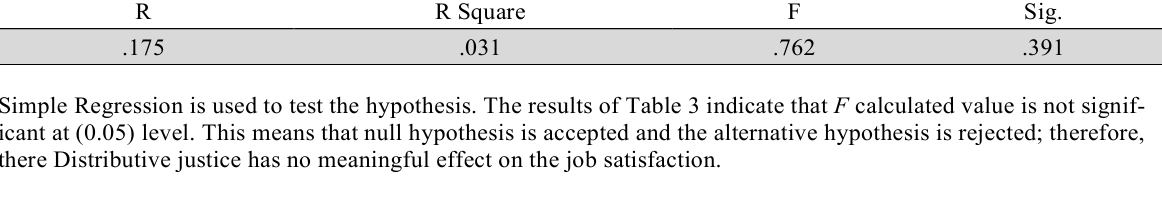
The results of testing the first sub-hypothesis R R Square F Sig. .175 .031 .762 .391